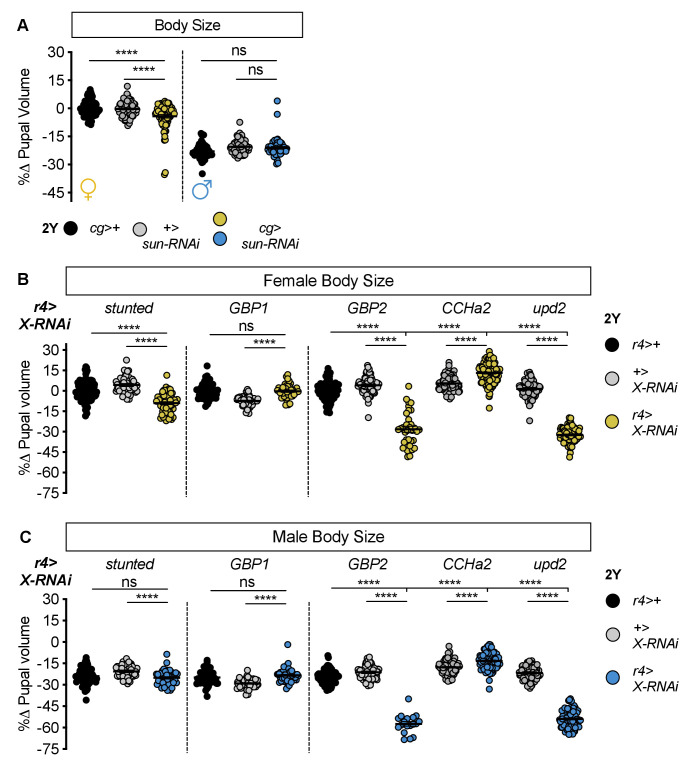
Most humoral factors have non-sex-specific effects on body size.(A) Pupal volume was significantly smaller in females with fat body-specific expression of an RNAi transgene directed against stunted (sun). Pupal volume was significantly reduced in cg>UAS-sun-RNAi females compared with cg>+ and +>UAS-sun-RNAi control females (p<0.0001 for both comparisons; two-way ANOVA followed by Tukey HSD test). This decreased pupal volume was not reproduced in cg>UAS-sun-RNAi males compared with cg>+ and +>UAS-sun-RNAi control males (p=0.3657 and p=0.9852, respectively; two-way ANOVA followed by Tukey HSD test). RNAi-mediated knockdown of sun had larger effects on pupal volume in females than in males (sex:genotype interaction p<0.0001; two-way ANOVA followed by Tukey HSD test). n = 54–85 pupae. (B) Pupal volume was significantly different in females with fat body-specific expression of RNAi transgenes directed against sun, Growth-blocking peptide 2 (Gbp2), CCHamide-2 (CCHa2), unpaired 2 (upd2) compared with r4>+ and +>UAS-X-RNAi control females (p<0.0001 for both comparisons [sun], p<0.0001 for both comparisons [Gbp2], p<0.0001 for both comparisons [CCHa2], p<0.0001 for both comparisons [upd2]; one-way ANOVA followed by Tukey HSD test); but not upon RNAi-mediated knockdown of Growth-blocking peptide 1 (Gbp1) (p=0.9665 and p<0.0001 respectively; one-way ANOVA followed by Tukey HSD test). n = 35–114 pupae. (C) Pupal volume was significantly different in males with fat body-specific expression of RNAi transgenes directed against Gbp2, CCHa2, and upd2 compared with r4>+ and +>UAS-X-RNAi control males (p<0.0001 for both comparisons [Gbp2], p<0.0001 for both comparisons [CCHa2], p<0.0001 for both comparisons [upd2]; one-way ANOVA followed by Tukey HSD test); but not reduced in males carrying RNAi transgenes directed against sun and Gbp1 (p=0.3513 and p<0.0001, respectively [sun]; p=0.1274 and p<0.0001, respectively [Gbp1]; one-way ANOVA followed by Tukey HSD test). n = 18–100 pupae. For body size graphs, filled circles indicate pupal volume and error bars indicate SEM. **** indicates p<0.0001; ns indicates not significant.